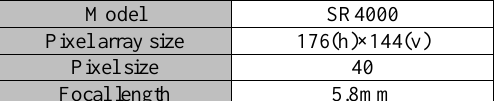
Table 2. Specifications of range sensor